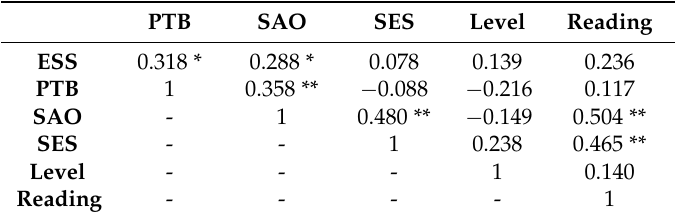
Table 2. Bivariate